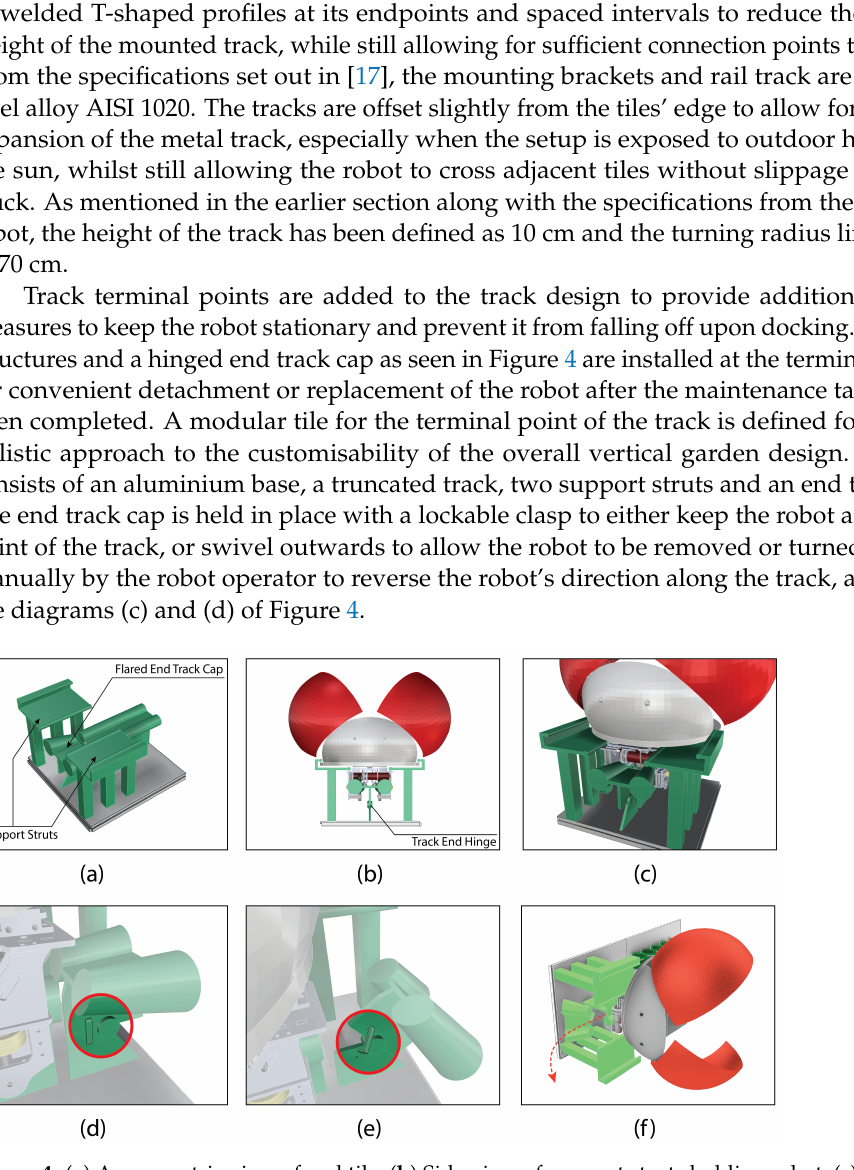
Figure 4. ( a ) Axonometric view of end tile, ( b ) Side view of support struts holding robot, ( c ) Close-up of robot stopped by flared track end cap, ( d ) Closed clasp during operation to prevent robot leaving track, ( e ) Open clasp for robot removal from track, ( f ) Method of removal for